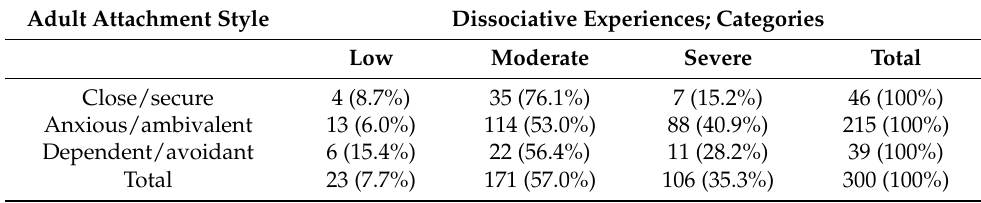
Table 3. Associations between categories of dissociation and attachment styles. Adult Attachment